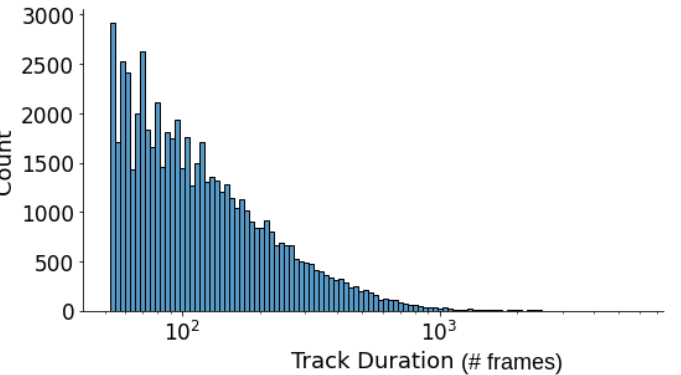
Figure 4. Distribution of tracklets durations in the UWG dataset. Longer tracklets capture more diversity within the same subject’s